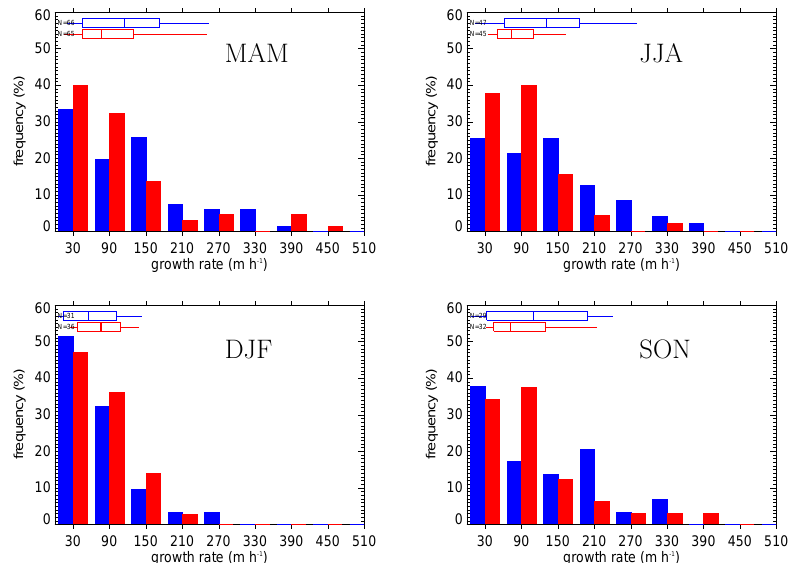
Figure 10. Frequency of occurrence of average growth rate of MLH between sunrise and time when 90% of MLH max is reached. Clockwise from top left are shown spring, summer, autumn and winter. Whisker boxes on top show 10, 25, 75 and 90% percentiles and the median.